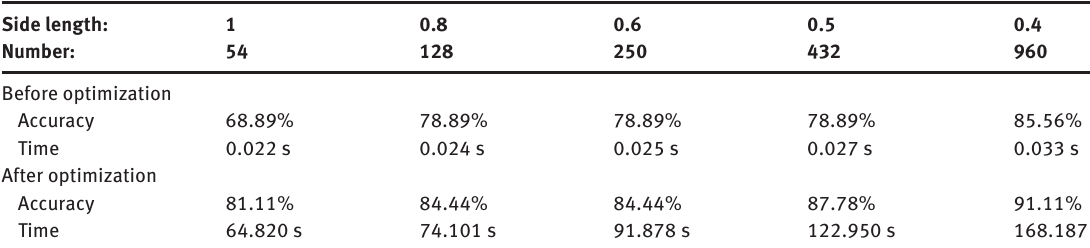
Table 4: Classification Accuracy Comparison with Different Subspace Sizes.